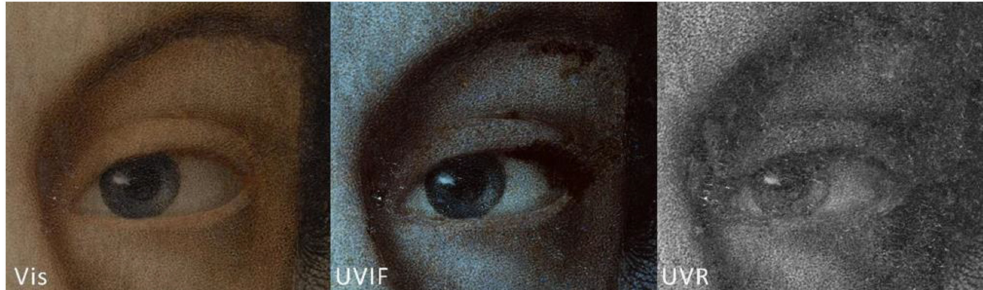
Figure 9. Comparison of images acquired using UV radiation. Induced fluorescence information, mainly retouching areas, are completed by those emerging by using reflected UV.